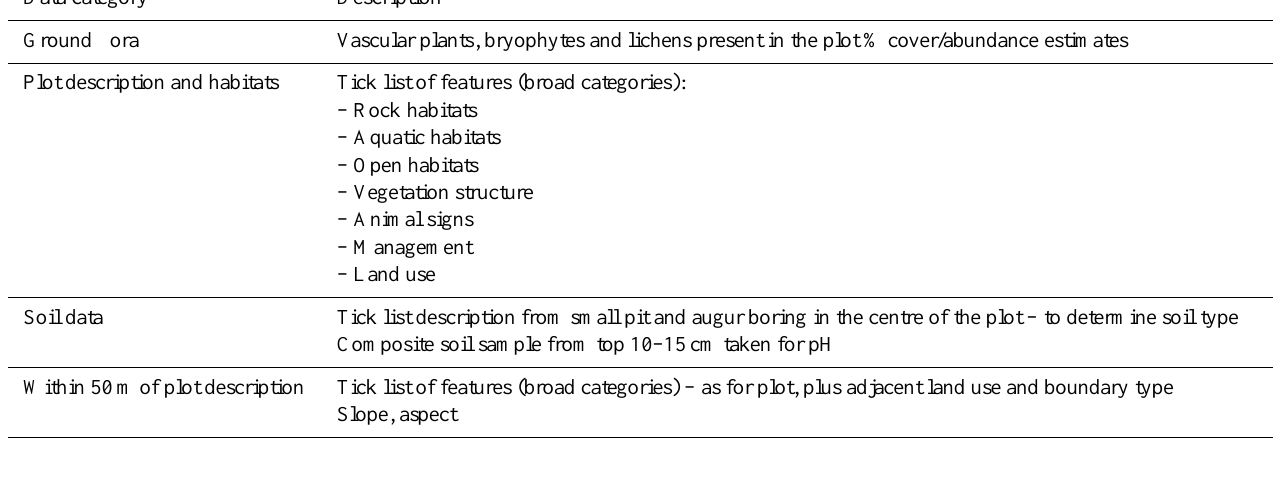
Table 2. Summary of data collected.